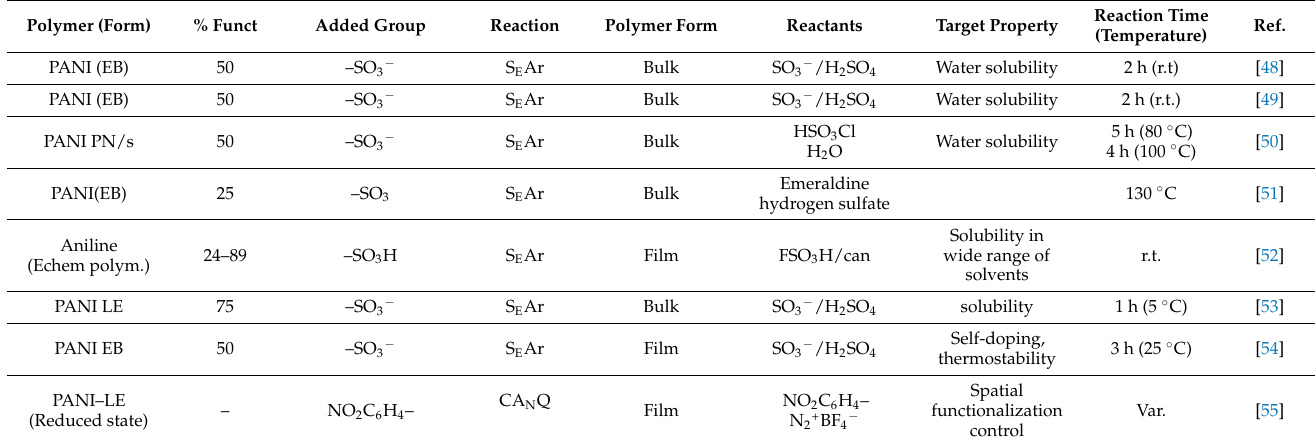
Table 1. Summary of reactions used in PANI postfunctionalization.